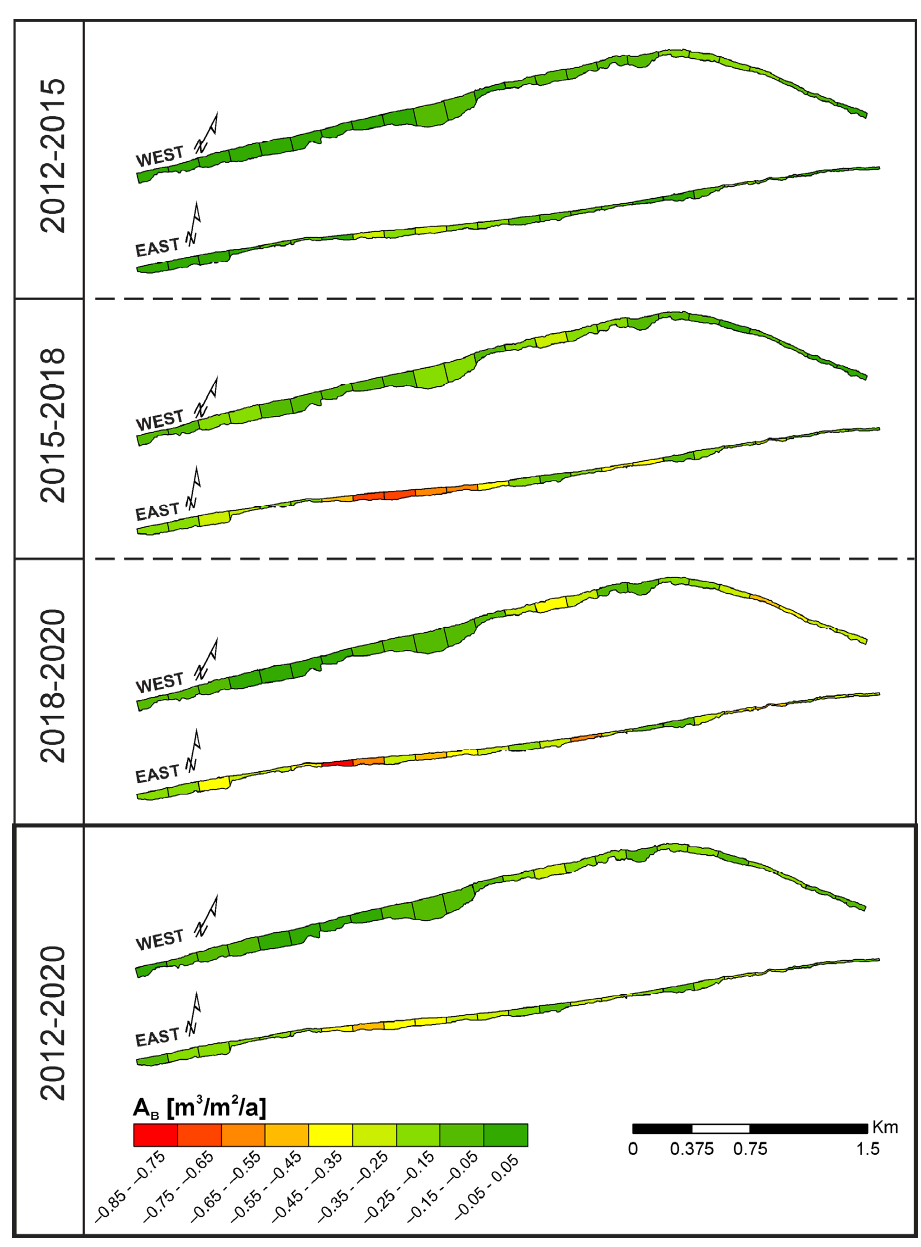
Figure 9. Figure showing the spatial distribution of the A B index in analyzed sectors in all research periods. Raw data source—Maritime Office in Szczecin.